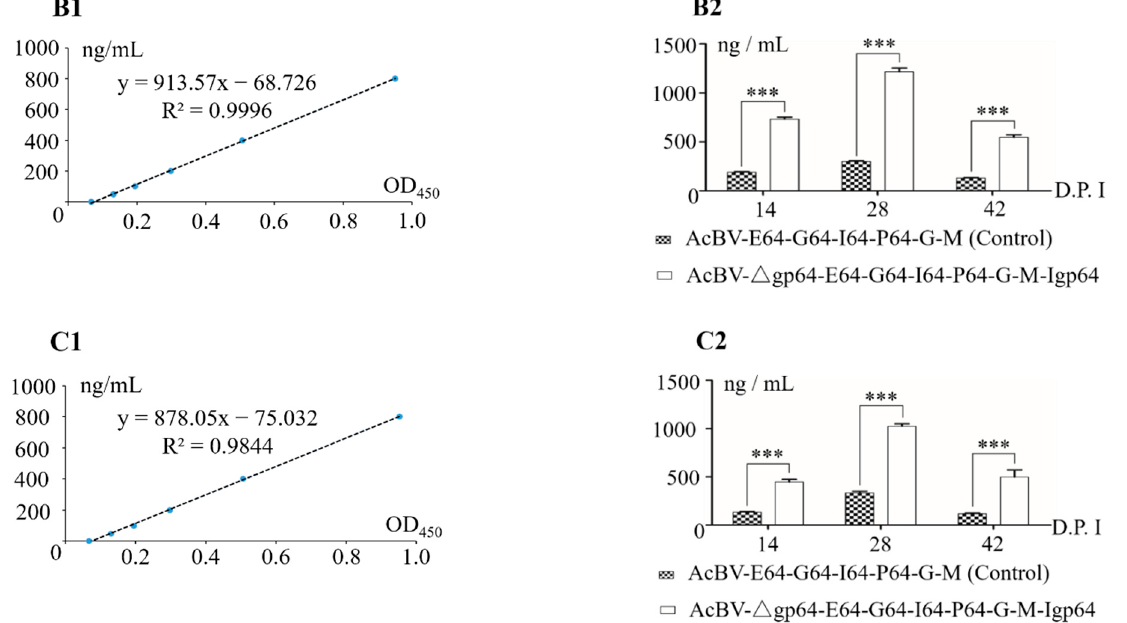
Figure 11. ELISA of serum-specific antibodies after immunization of mice with the recombinant baculovirus. ( A1 ) ELISA standard curve of serum specific antibodies ELISA (PCV2-ORF2—OD 450 ). ( A2 ) The serum-specific antibodies PCV2-ORF2 were determined by ELISA at different stages of immunizing mice with AcBV-E64-G64-I64-P64-G-M and AcBV- ∆ gp64-E64-G64-I64-P64-G-M-Igp64 (***: p < 0.01). ( B1 ) ELISA standard curve of serum-specific antibodies ELISA (PRRSV-GP5—OD 450 ). ( B2 ) The serum-specific antibodies PRRSV-GP5 were determined by ELISA at different stages of immunizing mice with AcBV-E64-G64-I64-P64-G-M and AcBV- Δ gp64-E64-G64-I64-P64-G-M-Igp64 (***: p < 0.01). ( C1 ) ELISA standard curve of serum-specificfd antibodies ELISA (CSFV-E2—OD 450 ). ( C2 ) The serum-specific antibodies CSFV-E2 were determined by ELISA at different stages of immunizing mice with AcBV-E64-G64-I64-P64-G-M and AcBV- Δ gp64-E64-G64-I64-P64-G-M-Igp64 (***: p < 0.01).